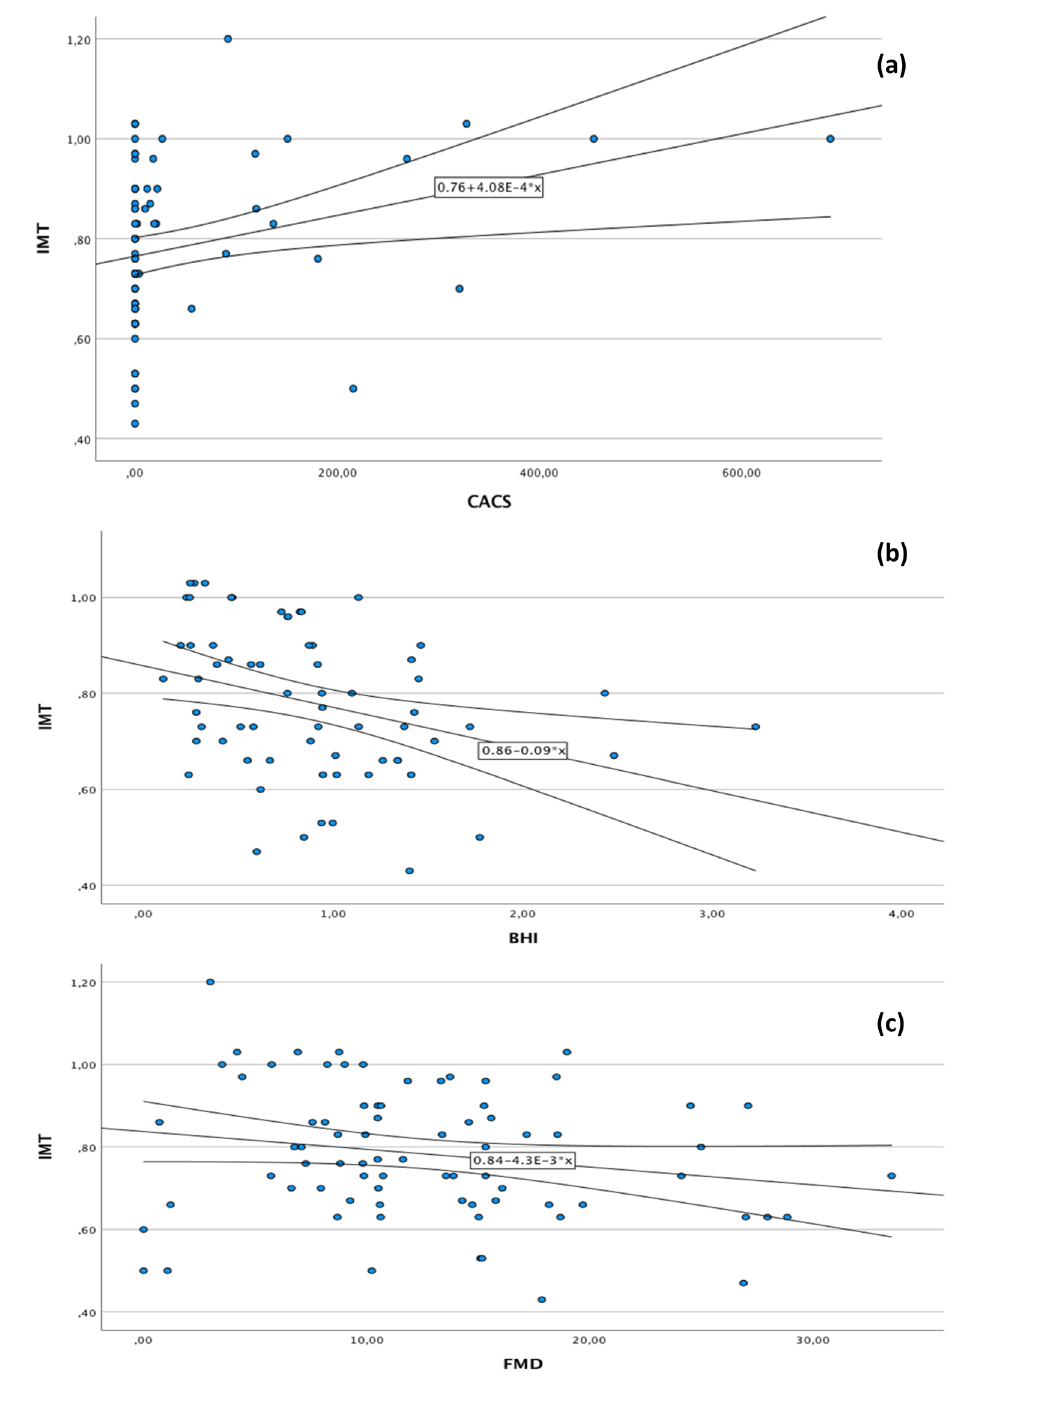
Figure 2. Correlation between IMT and other subclinical atherosclerosis and endothelial dysfunction tests. ( a ) IMT versus CAC scatter plots with 95% CI linear fit. ( b ) IMT versus BHI scatter plots with 95% CI linear adjustment. ( c ) IMT versus FMD scatter plots with linear 95% CI